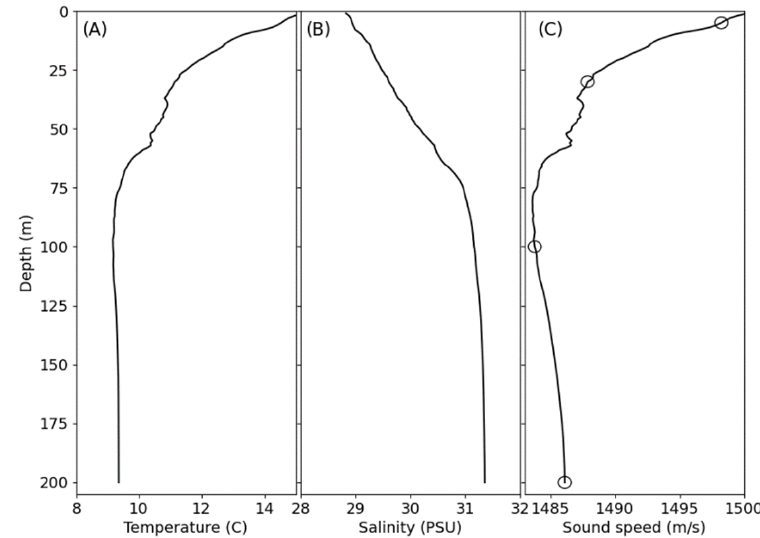
Figure 9. Temperature ( A ), salinity ( B ), and corresponding sound-speed ( C ) profiles obtained during the study on 1 September 2021 in the middle of Saanich Inlet. The four circles in ( C ) indicate the depths of the four passive acoustic recorders.